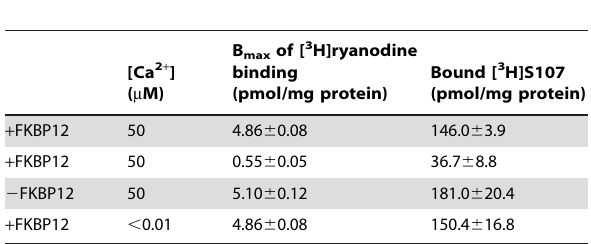
Table 1. [ 3 H]S107 binding to SR vesicles.